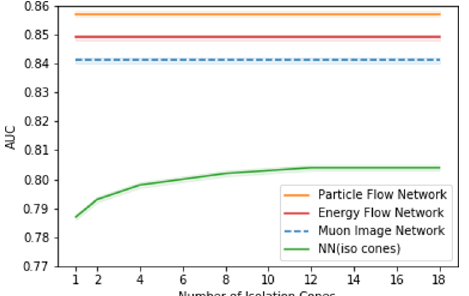
Figure 3. Comparison of classification performance using the metric AUC between Particle-Flow networks trained on lists of calorimeter deposits (orange, solid), Energy-Flow networks trained on lists of calorimeter deposits (red, solid), convolutional networks trained on muon images (blue, dashed) and networks which use increasing numbers of isolation cones (green, solid). For each number of cones, the optimal set is chosen.